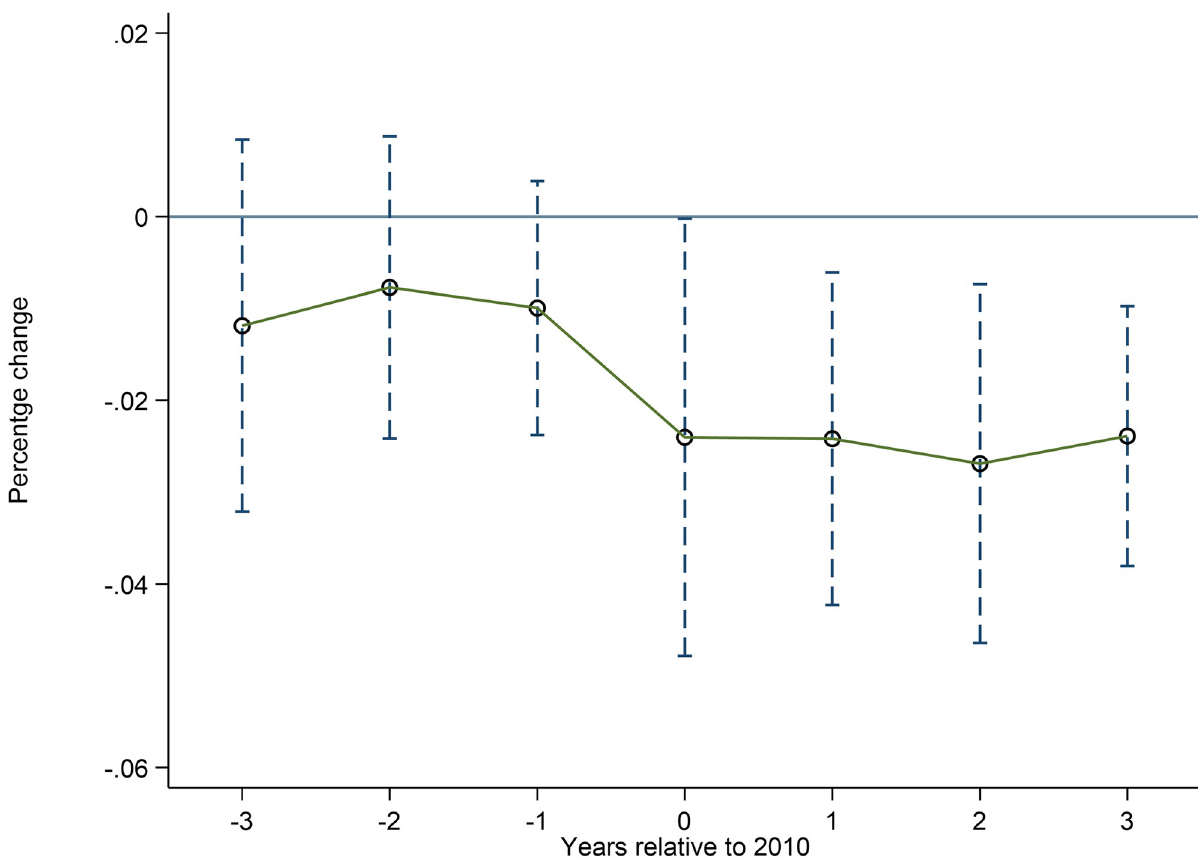
Fig 3. The dynamic impact of rural infrastructure on poverty. The impact of implementation of the policy on rural poverty rates 3 years before the until 3 years after deregulation. https://doi.org/10.1371/journal.pone.0266528.g003 Table 6. Result of two-stage least square